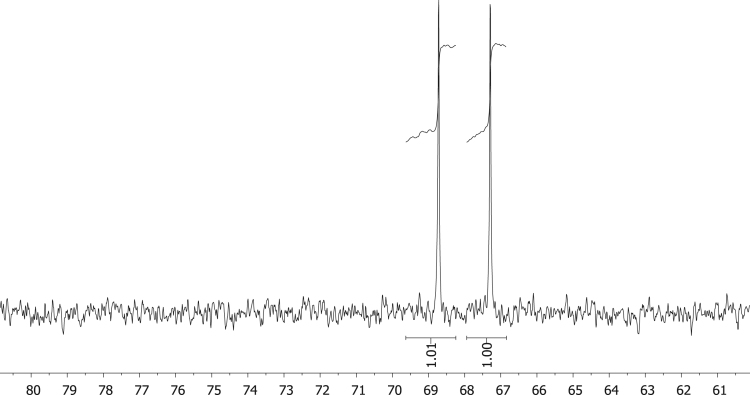
31P NMR of [Rh(acac)CO(C6H4NHPPh2)], 5.